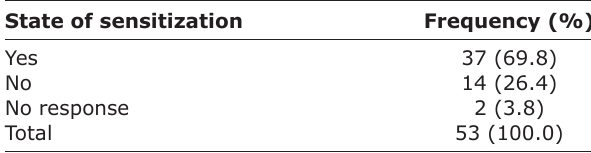
Table-3: Respondents’ states of sensitization about the OH approach.